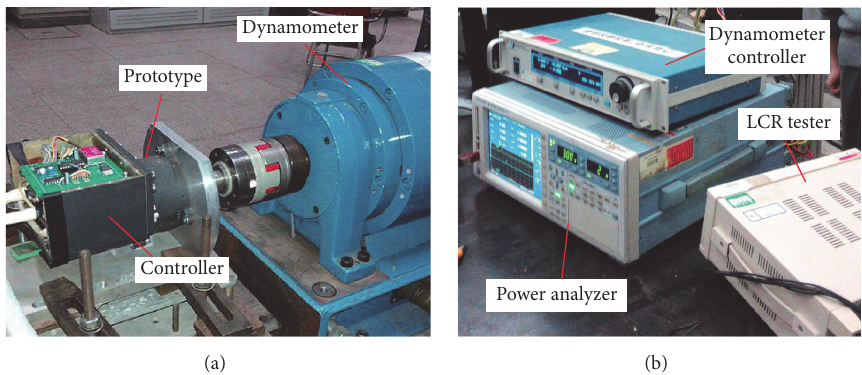
Figure 8: Prototype and measuring instruments. (a) Prototype, controller, and dynamometer. (b) Dynamometer controller, power analyzer, and LCR tester.